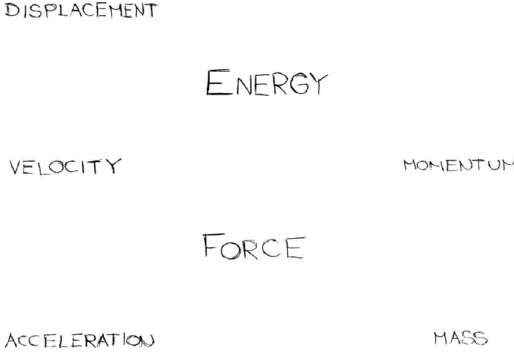
FIG. 1. The fundament sheet containing the seven fundamental concepts identified from the outline for the mechanics module.